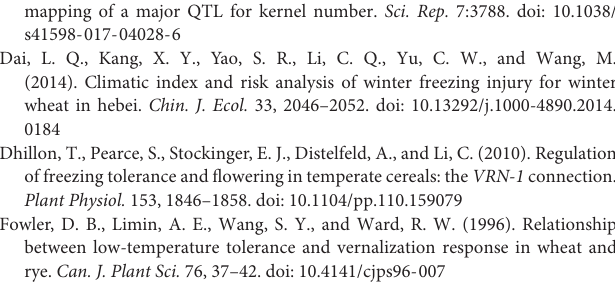
Supplementary Figure 1 | Breeding procedure of wheat cultivar Lunxuan 103. Supplementary Figure 2 | Average daily maximum (A) and minimum (B) temperatures at five environments during wheat cropping seasons (from October of the first year to June of the next year). Supplementary Figure 3 | Category analysis of the genes identified by the common SNPs (CG), specific SNPs of Shimai 12 to Lunxuan 103 (SG-SM12), specific SNPs of Shijiazhuang 8 to Lunxuan 103 (SG-SJZ8), and specific SNPs to Lunxuan 103